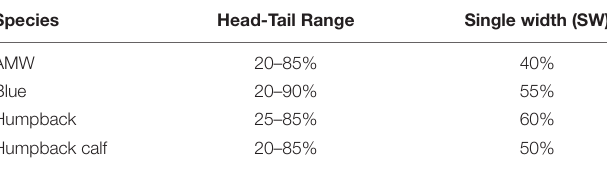
TABLE 1 | The Head-Tail Range and single width (SW) measurement for each species used for measuring body condition.